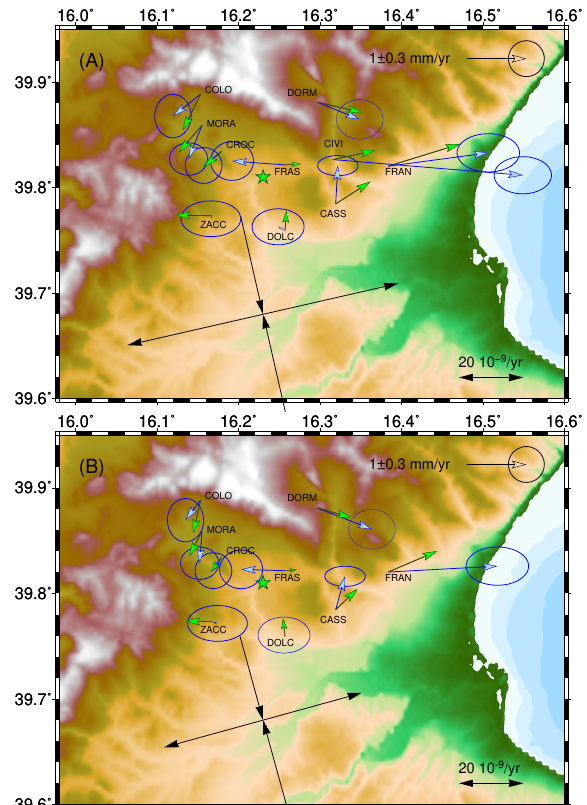
Figure 3. ( A ) Comparison between observed and modelled surface velocities (blue and green arrows, respectively) according to the inversion scheme R (see Table 3), after the removal of the estimated rigid-body motion. The ellipses represents the one-sigma errors from GNSS data analysis (observational errors) and should be rescaled by the square root of the estimated hyper-parameter α in order to √ α = 2.18 for this inversion). The regional strain rate is also drawn, account for the modelling errors ( further south with respect to the reference point ( φ 0 , θ 0 ) of the Taylor series expansion (green star). √ α = 1.45), where the CIVI station has ( B ) As panel A, but for the inversion scheme R* (see Table 3, not been